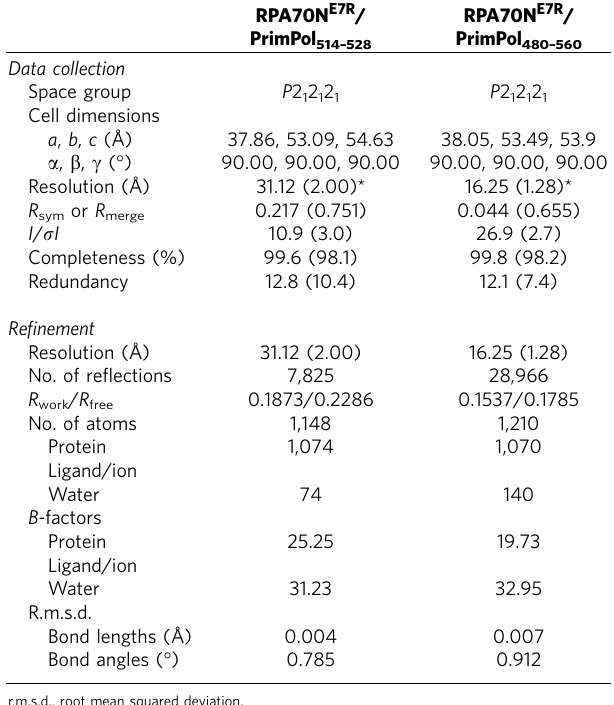
Table 1 | Data collection and refinement statistics (molecular